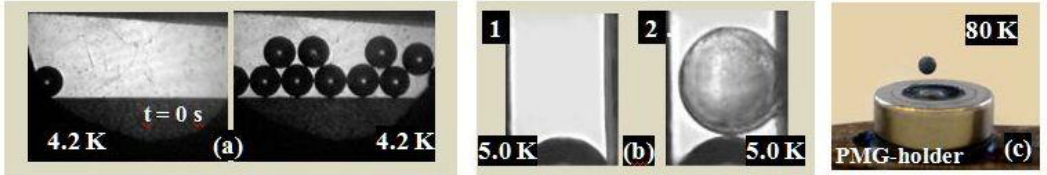
Figure 11. (a–c): A set of the injection experiments at cryogenic temperatures. Figure 11. ( a – c ): A set of the injection experiments at cryogenic